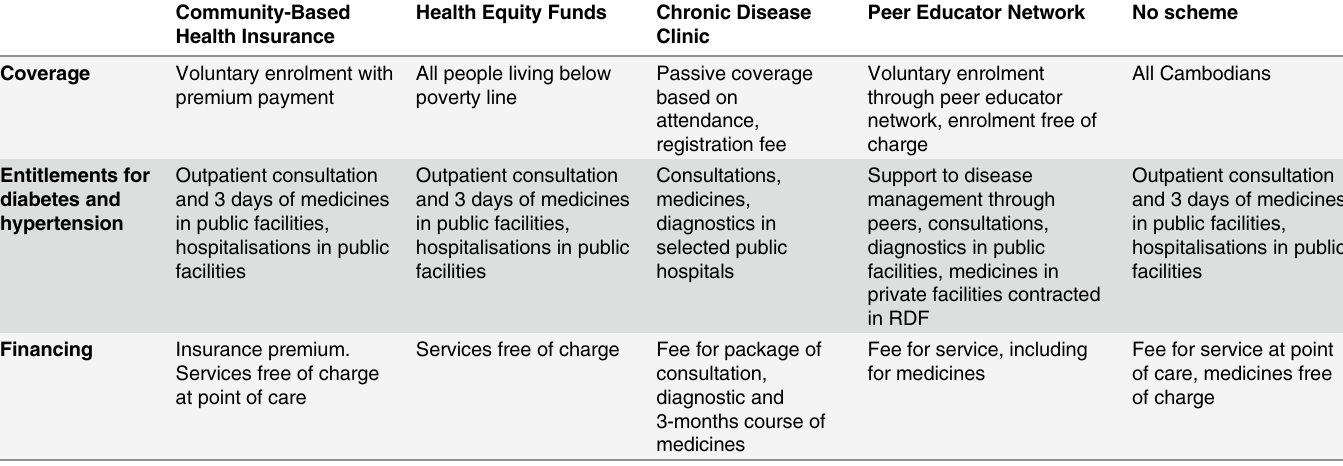
Table 1. Description of schemes and respective entitlements for people with diabetes and hypertension. Community-Based Health